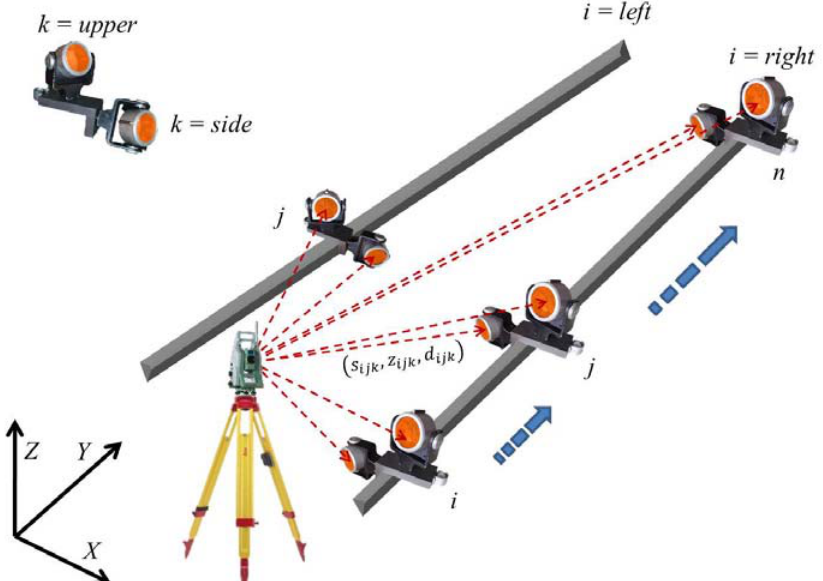
Figure 3. Schematic illustration of